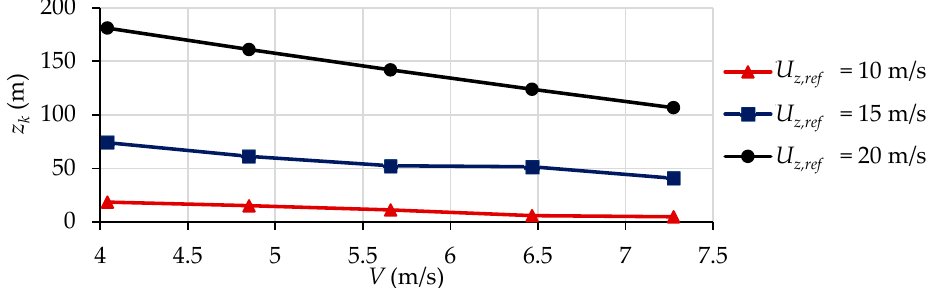
Figure 13. The optimal kite elevations for different ship and wind speeds and a kite area of 320 m 2 .